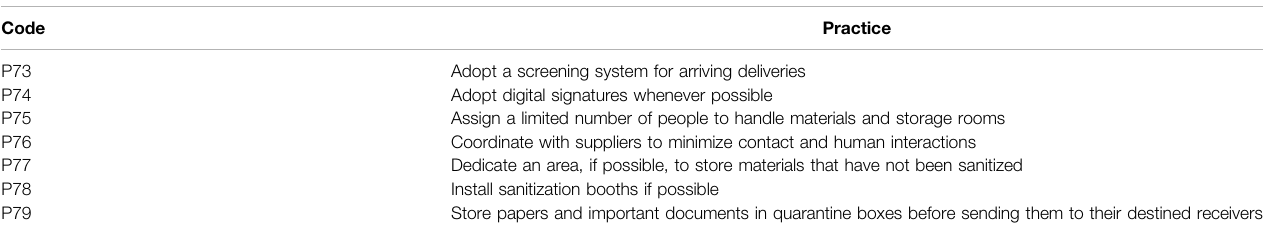
TABLE 11 | Recommended practices to manage and handle